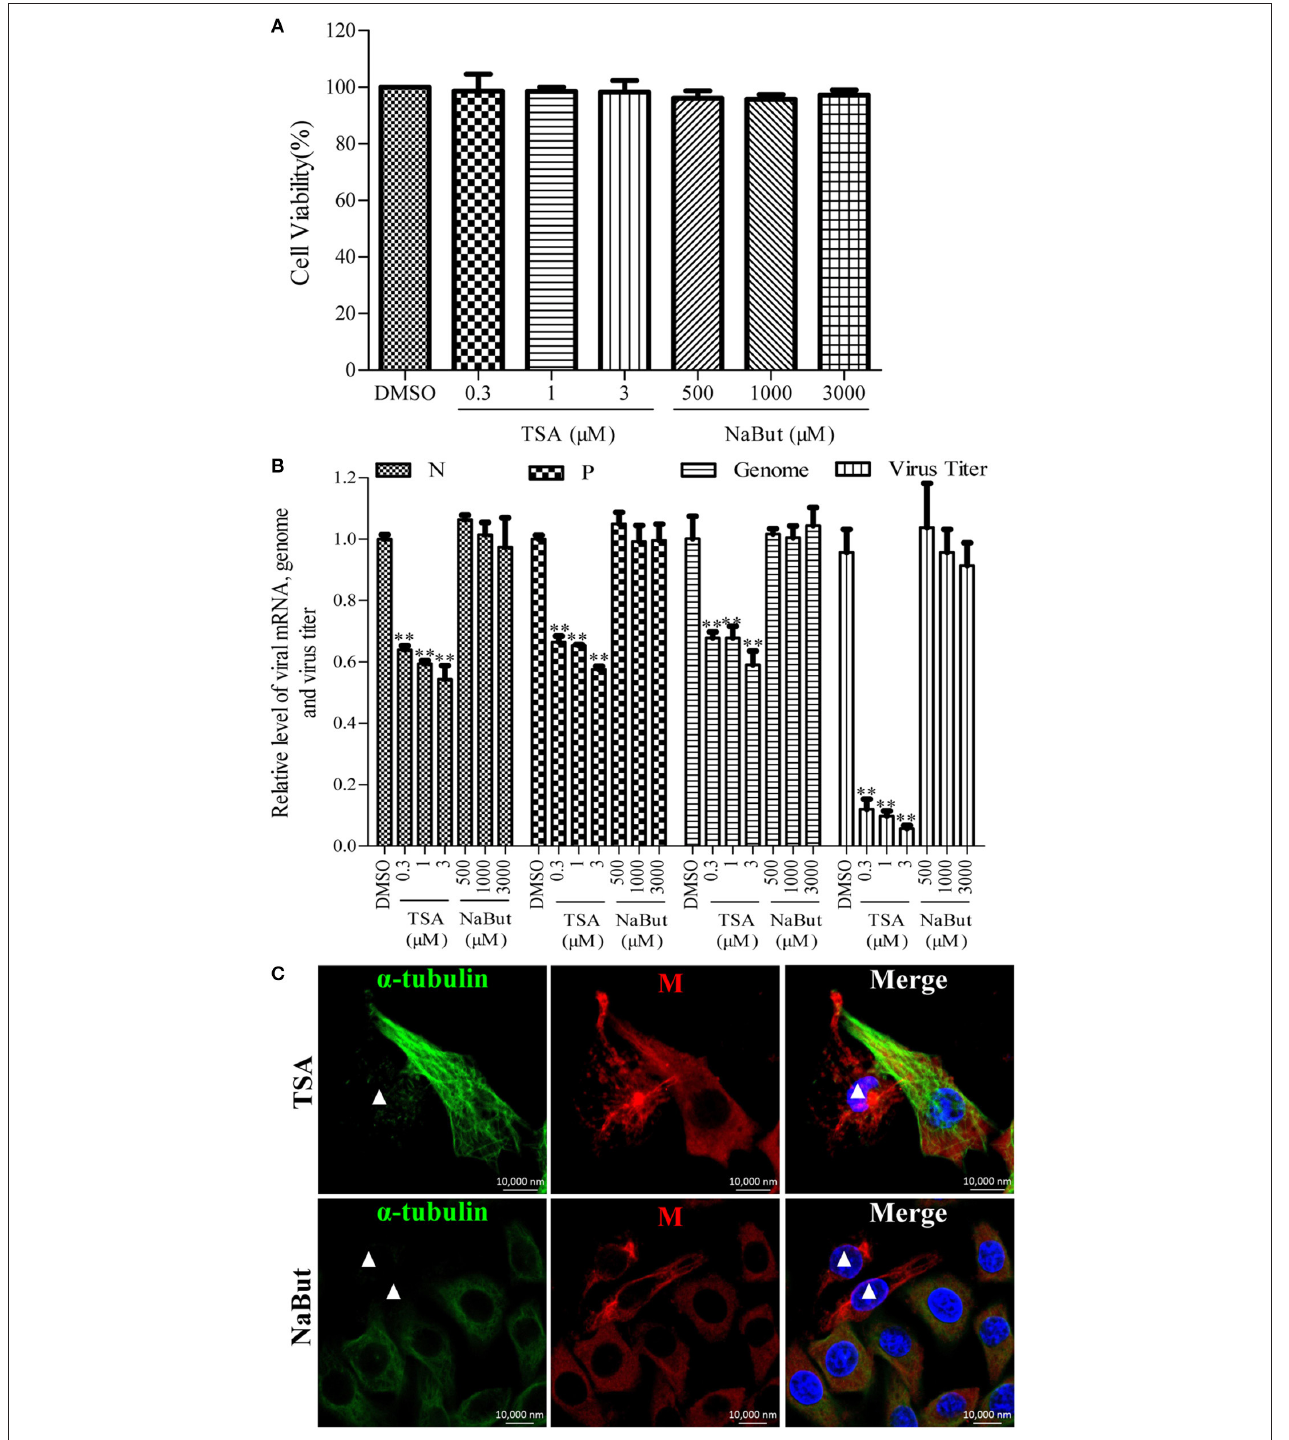
FIGURE 4 | Effects of inhibiting the deacetylase activity of HDAC6 on viral RNA synthesis. (A) The detection of the cell viability of N2a cells incubated with TSA, NaBut, or DMSO (as control) for 20 h by CCK-8. (B) N2a cells were infected with RABV for 4h and then incubated with TSA, NaBut, or DMSO for another 20 h and the cells were collected for viral RNA extraction. Quantitative real-time PCR was performed to detect the viral genes and genome. The titers of infectious RABV progeny from the culture supernatants were determined by TCID 50 . (C) The distribution of the viral M protein (red) and microtubule cytoskeleton (green) in RABV-infected N2a cells in the presence of TSA or NaBut at 24 hpi. Nuclei (Nuc) were stained with DAPI (blue). The white triangles indicate the cells which have a filamentous network viral M protein and disrupted microtubules. Scale bars, 10,000nm. Data are represented as the means ± SD ( n = 3; **represents P < 0.01).